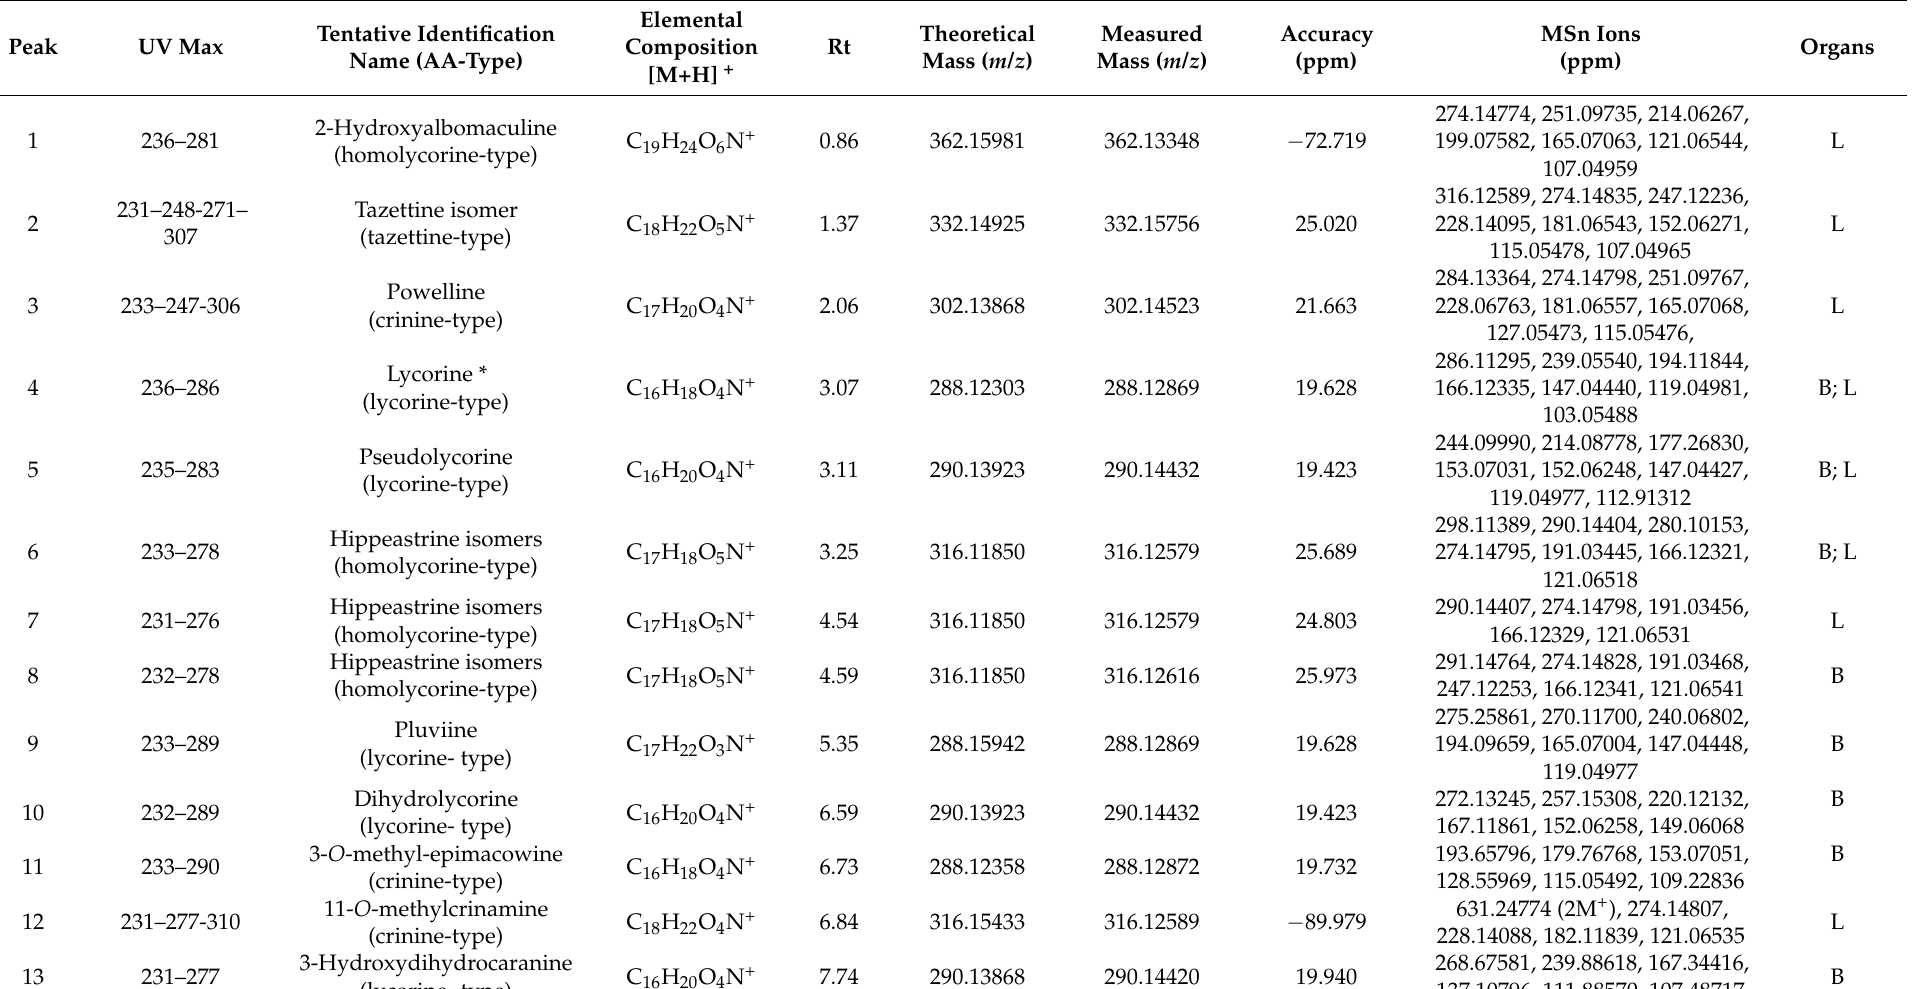
Table 1. Ultrahigh performance liquid chromatography orbitrap mass spectrometry (UHPLC-Orbitrap-MS) identification of Phycella cyrtanthoides